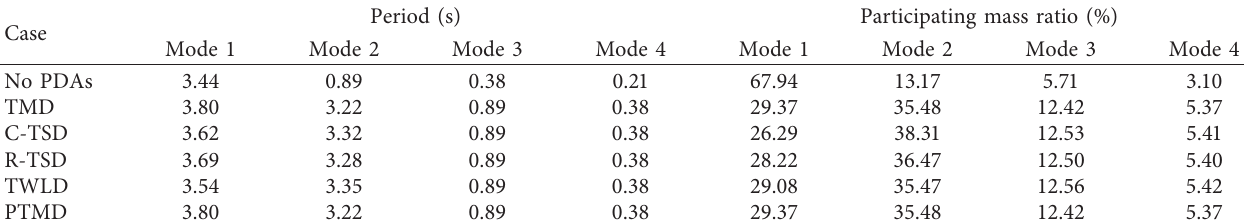
Table 16: Periods and participating mass ratios for yz plane of the building with a single PDA: seismic load.